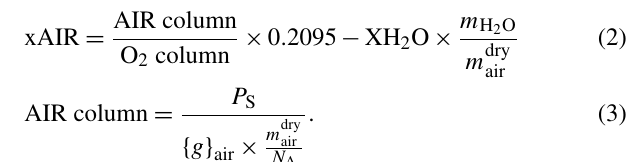
Up to 9 Mar 2010 ECL02 V01 0.4 –